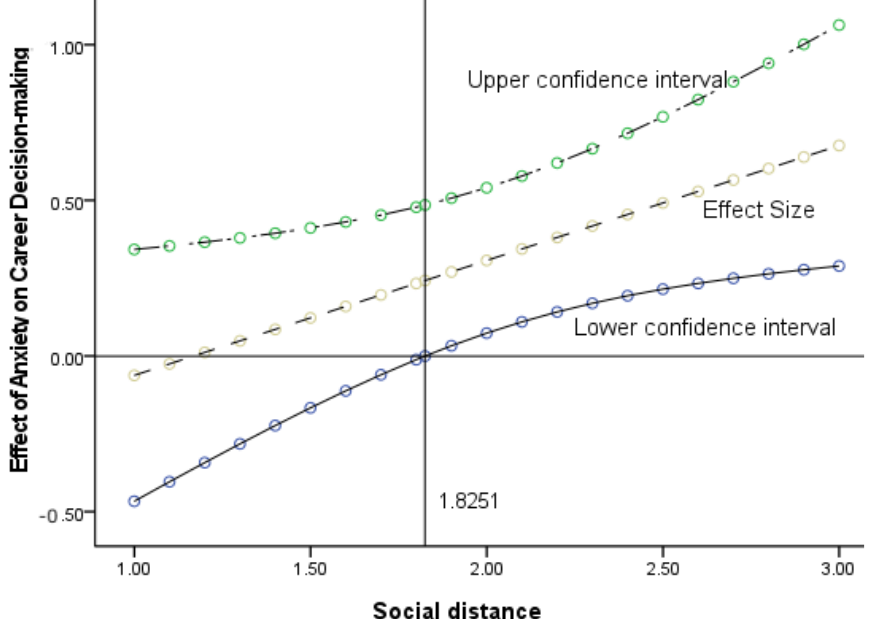
Figure 3. The relationship between anxiety and intuitive career decision making at different social distances. social